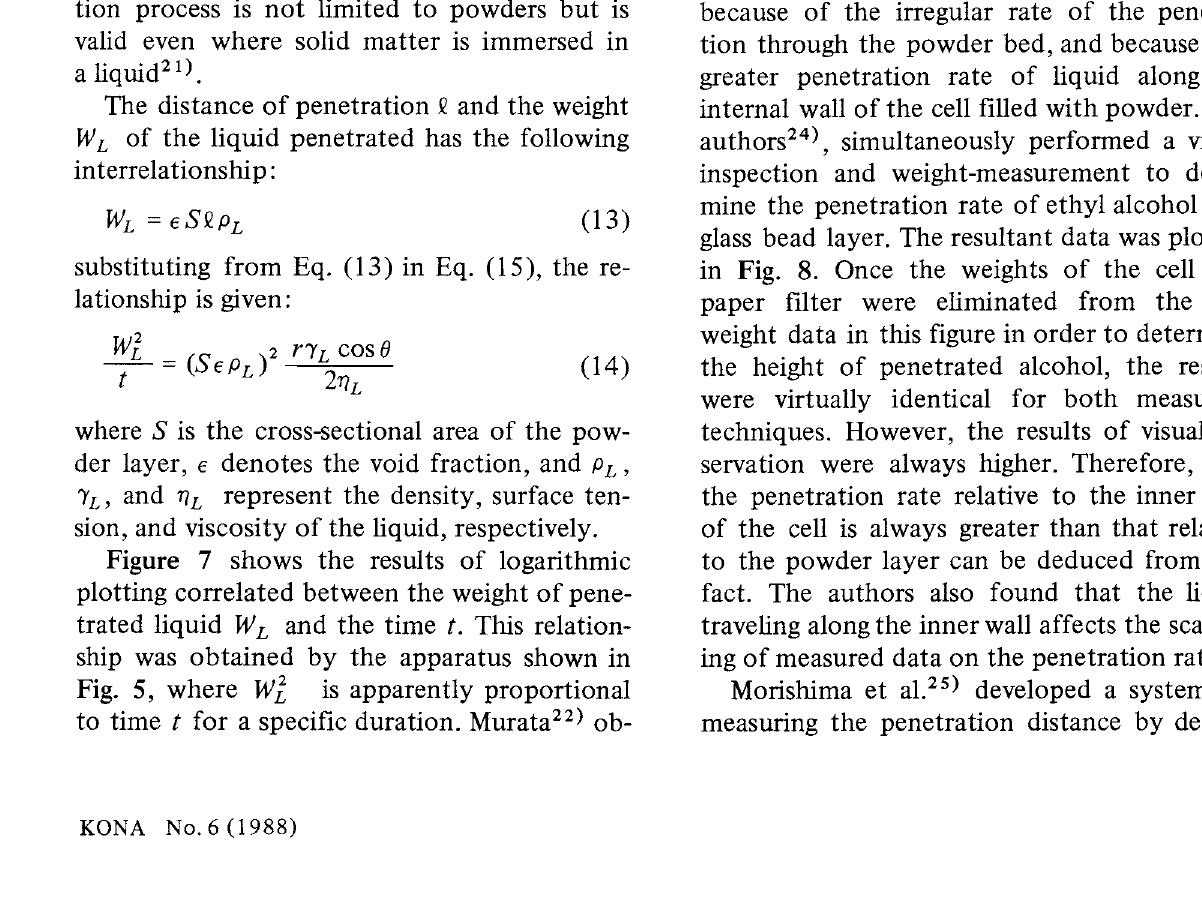
filled with powders comes into contact with the liquid surface, the surface tension of the liquid excludes the cell from the surface. In contrast with this action when the tray is fur ther lifted, the cell receives a suction force by the sur(ace tension, and, then, the cell also receives floatation from the portion immersed in the liquid. After the tray is stopped lifting, the liquid penetrates through the powder layer.